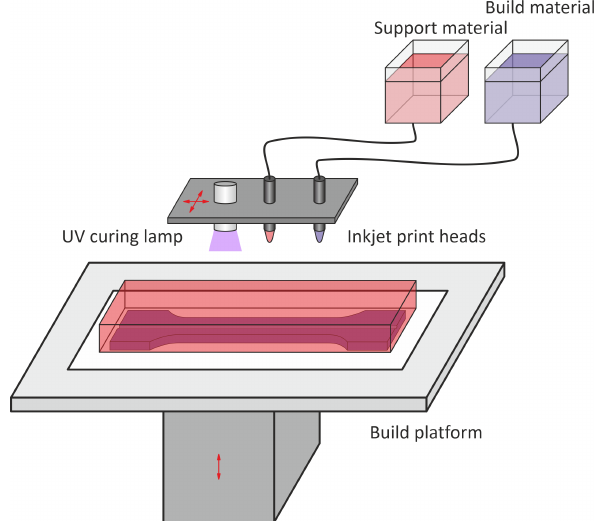
Figure 1. Multi-jet printing (MJP) printing